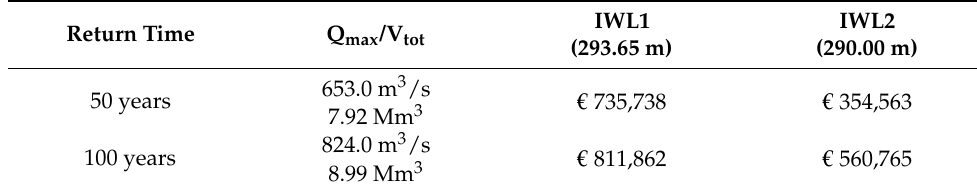
Table 4. Total damage in Euro for different hydrological input and IWLs. Return